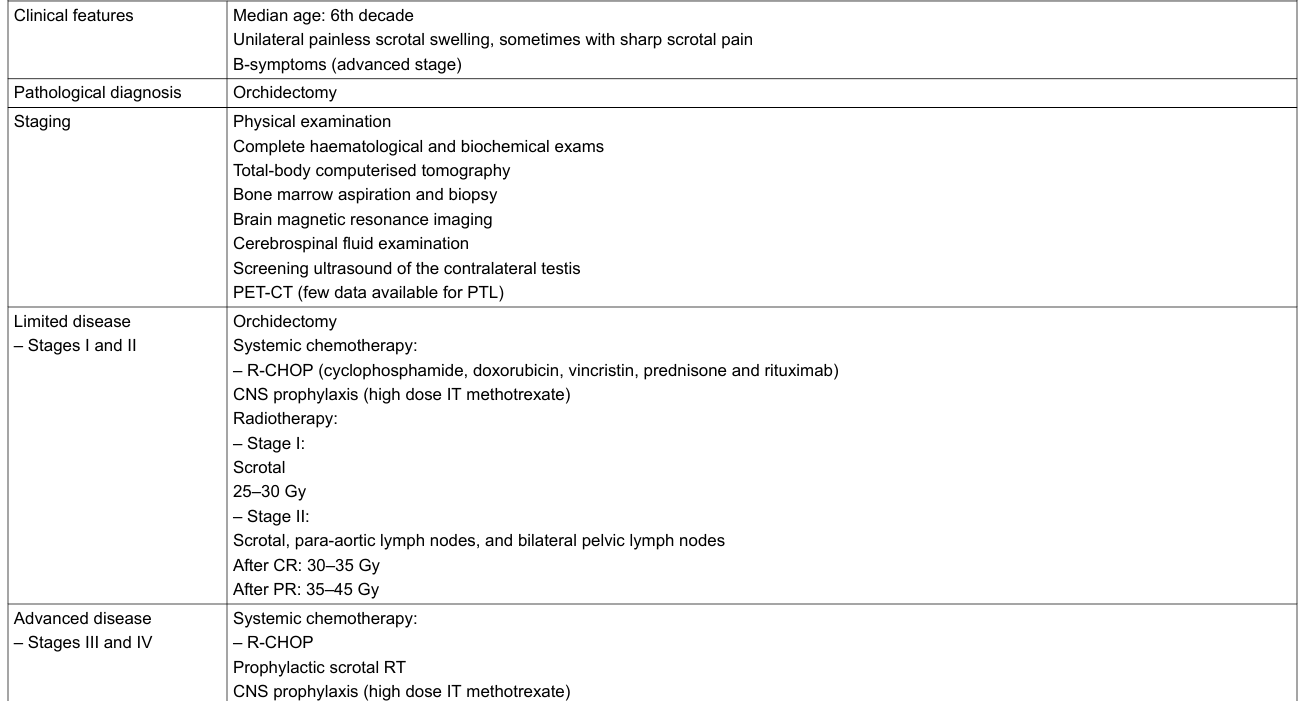
Table 2 Diagnostic and therapeutic algorithms in patients with primary testicular lymphoma (PTL). Clinical